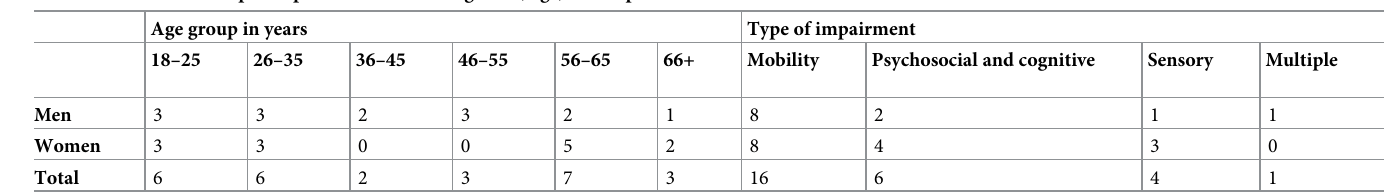
Table 1. Distribution of participants based on their gender, age, and impairment.